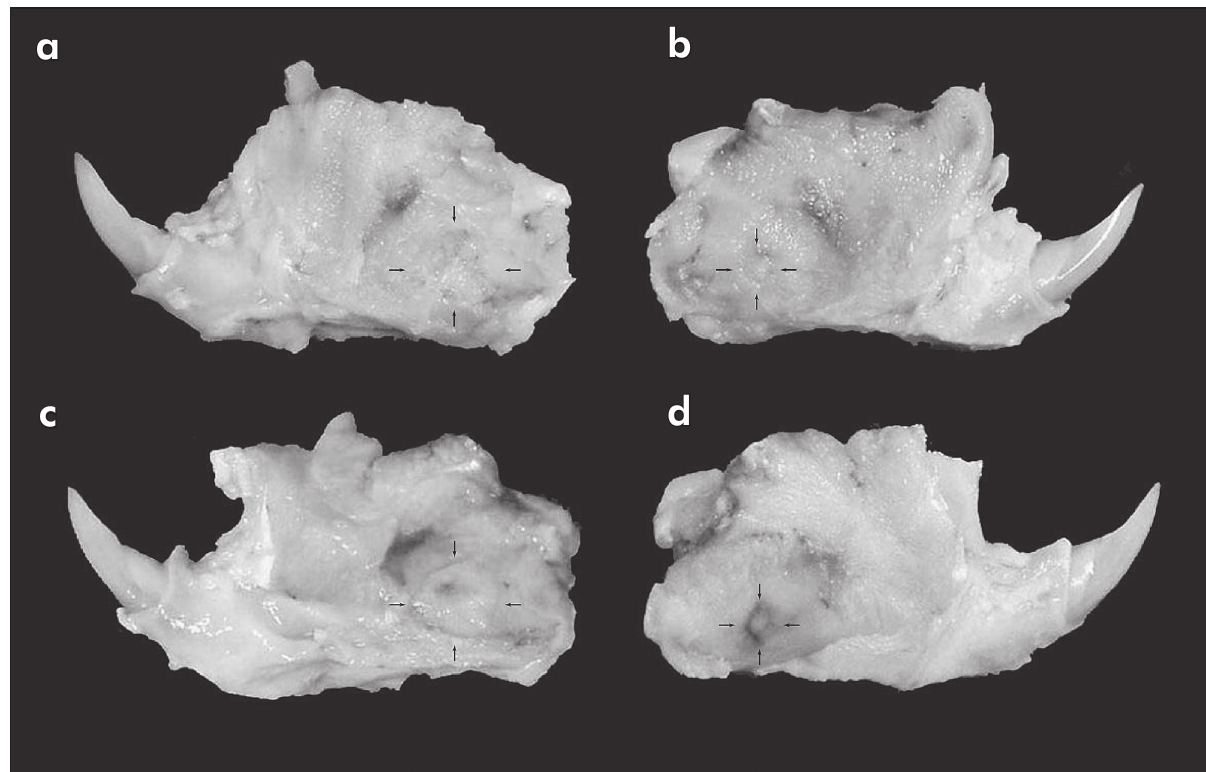
Figure 1 - Specimens on the 90 th postoperative day. ( a ) left side SHR. ( b ) right side SHR. ( c ) left side WKY. ( d ) right side WKY. The defect contours are still visible with few signs of bone